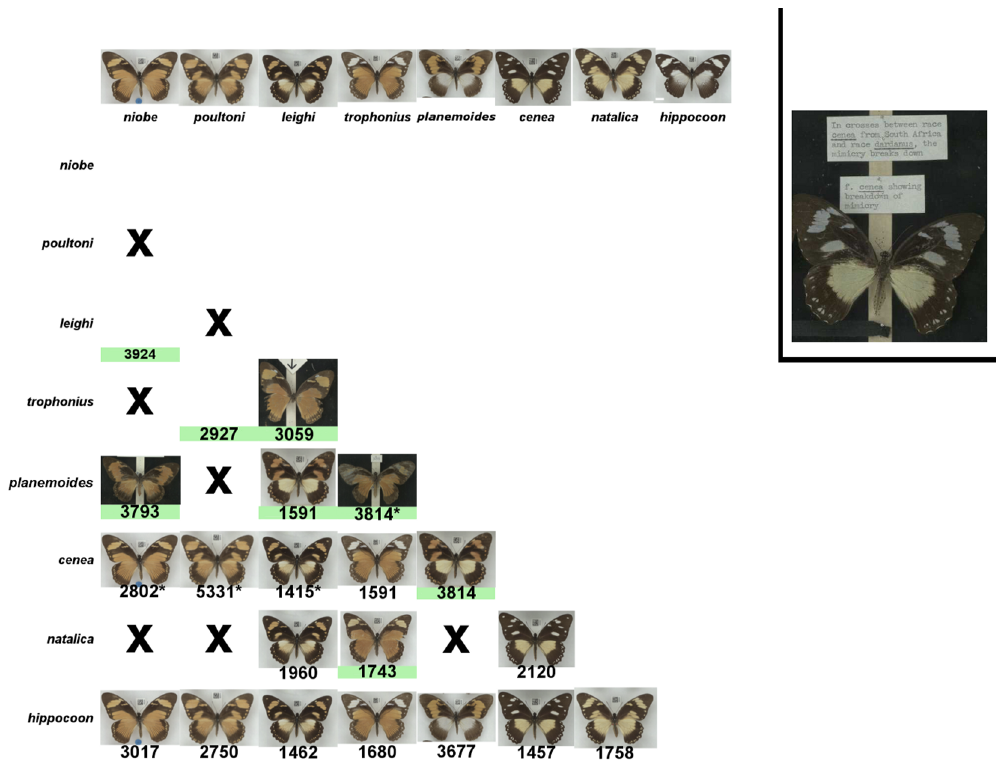
Figure 2. Inheritance of female wing patterns in Papiliodardanus . Overview of the crosses performed by Clarke and Sheppard in the 1950s and 1960s. Asterisks indicate crosses with variable outcomes that range from complete dominance to breakdown of mimicry. Green shading indicates incomplete dominance (production of intermediate phenotype). Where possible, intermediates are taken from the Clarke/Sheppard/Turner collection [40], otherwise insects were chosen from wild-caught specimens, which match the descriptions given in the published manuscripts. Most intra- subspecific crosses follow a strict dominance hierarchy, with only a few exceptions. For example, crosses between co-occurring forms f. trophonius and f. natalica produce butterflies where the dominant phenotype (f. trophonius ) shows atypical tawny tinted forewing patches. In contrast, inter- subspecific crosses often produced aberrant butterflies. For example, on crossing a P. dardanus dardanus f. cenea with a male from a West African population of P. dardanus dardanus , which lacks this form, the female progeny no longer possessed accurate mimicry of Amauris echeria , but displayed an intermediate pattern (inset).